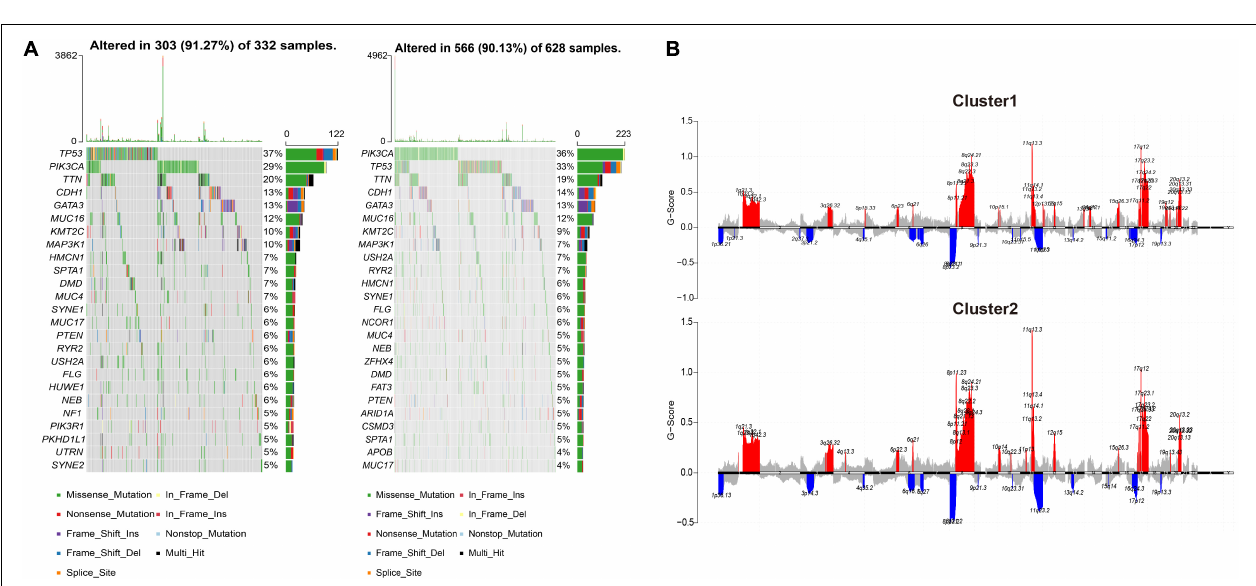
FIGURE 1 | The difference in characteristics and genomic features between two subgroups. (A) The heatmap showed clusters of 1,274 genomic variation features. Sample annotations show the different clinical characteristics. (B) The sample proportion of the two subgroups. (C) Kaplan–Meier curve showed the overall survival in patients between cluster 1 and cluster 2 ( p < 0.001). (D) The MSI burden, mTMB, and SCNA burden of each cluster. (E) The box plots showed the mTMB burden between cluster 1 and cluster 2. *** p < 0.001.